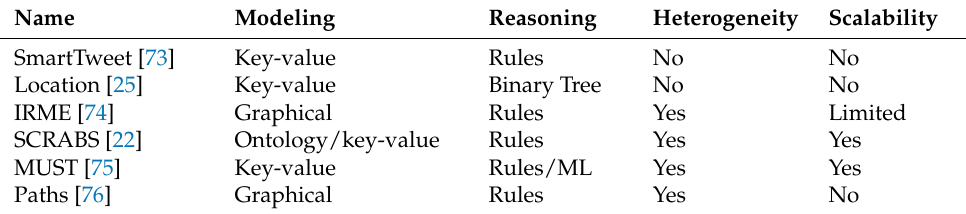
Table 1. Overview of middleware for CH